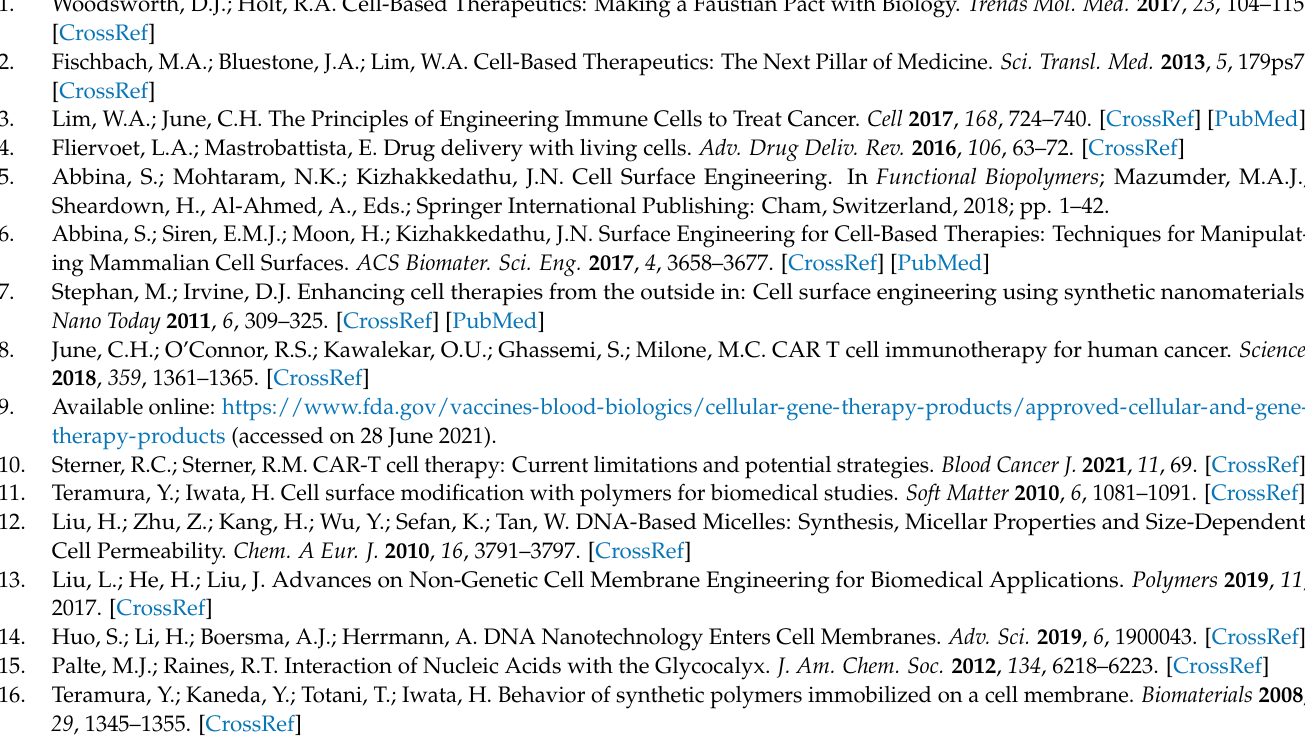
Figure S2: RBCs hemolysis induced by insertion of amphiphilic cargoes. Figure S3: In vitro pumping- generated shear stress induced release of lipo (EG)n-inserted on RBC. Figure S4: Confocal images of lipo-PEG inserted RBC before and post injection. Figure S5: Structures of commercial DSPE-PEG2K and cationic C18PEG2K amphiphiles. Figure S6: Cationic C18PEG2K greatly improves the in vitro stability when loaded on RBC